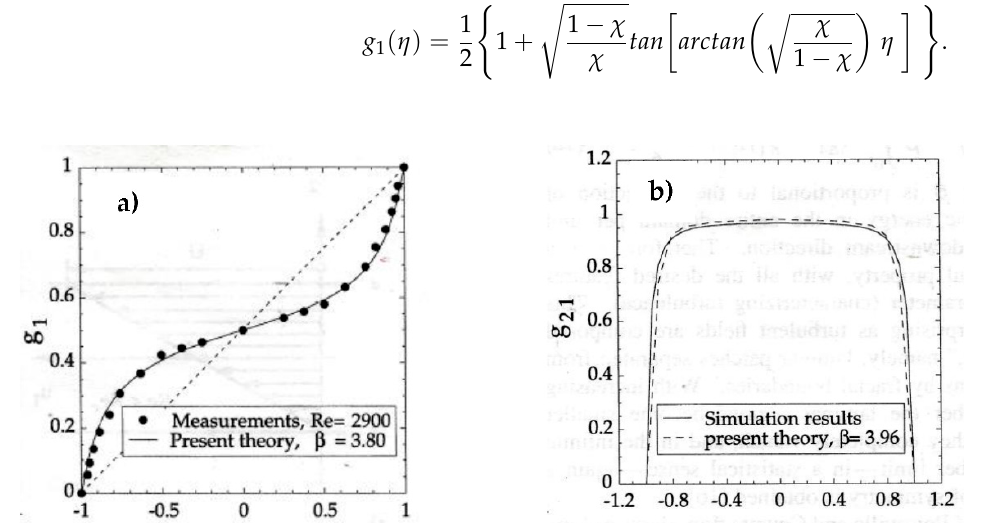
Figure 5. ( a ) Comparison of the theoretical mean velocity profile (see Equation (12) with β = 3.8 and α from Equation (13) or Figure 6, respectively) with experimental data from Reference [32]. The mean velocity profile is nonlinear and S-shaped (here in a mirrored picture). In the infinite Reynolds number limit the distribution is a constant g 1 ≡ 1/2 , fulfilling the boundary conditions (11) by the occurrence of two discontinuities at the boundaries. ( b ) In the second figure a comparison of the theoretical Reynolds stress (see Equation (14) below with β = 3.96 and α from Equation (13) or Figure 6, respectively) with numerical simulation results from [33] is presented. In the infinite Reynolds number limit the distribution is a constant g 21 ≡ 1 , fulfilling the boundary conditions g 21 ( ± 1 ) = 0 by the occurrence of two discontinuities at η = ± 1. Reprinted with permission from Egolf and Weiss (1995a) © 2021, American Physical Society.